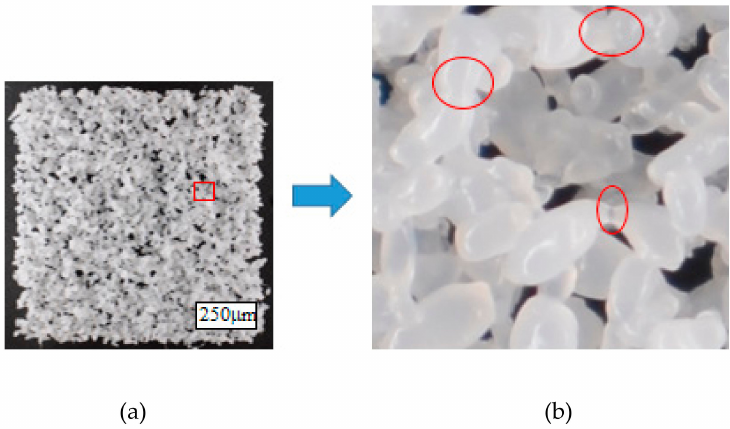
Figure 1. A primitive layer of 1 cm scanned by the CO 2 laser at p = 5.2 W, d = 0.1 mm, and V = 100 mm / s. (a) the clean definition of the edges; (b) the neck formation between the particles in a 50 × magnified